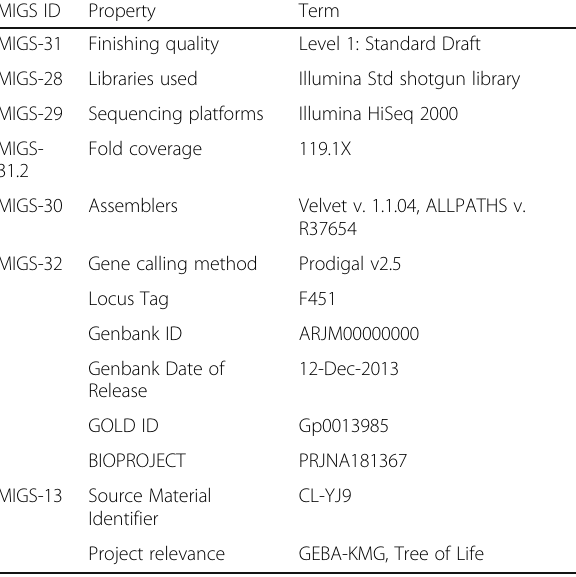
Table 2 Genome sequencing project